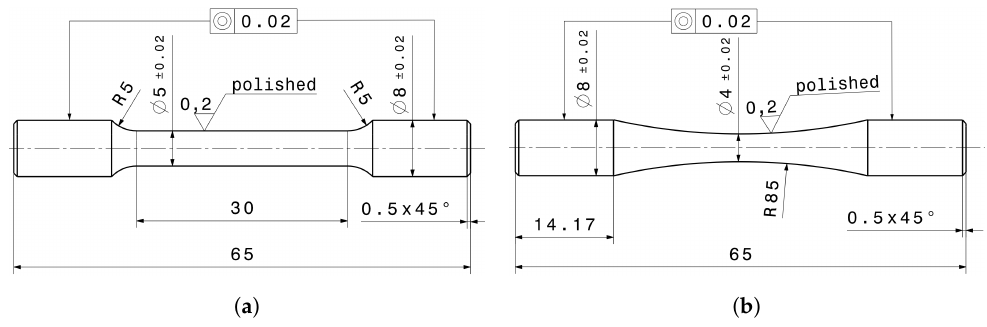
Figure 3. Geometry of test specimen in [mm]. ( a ) Quasi-static tensile test. ( b ) Fatigue